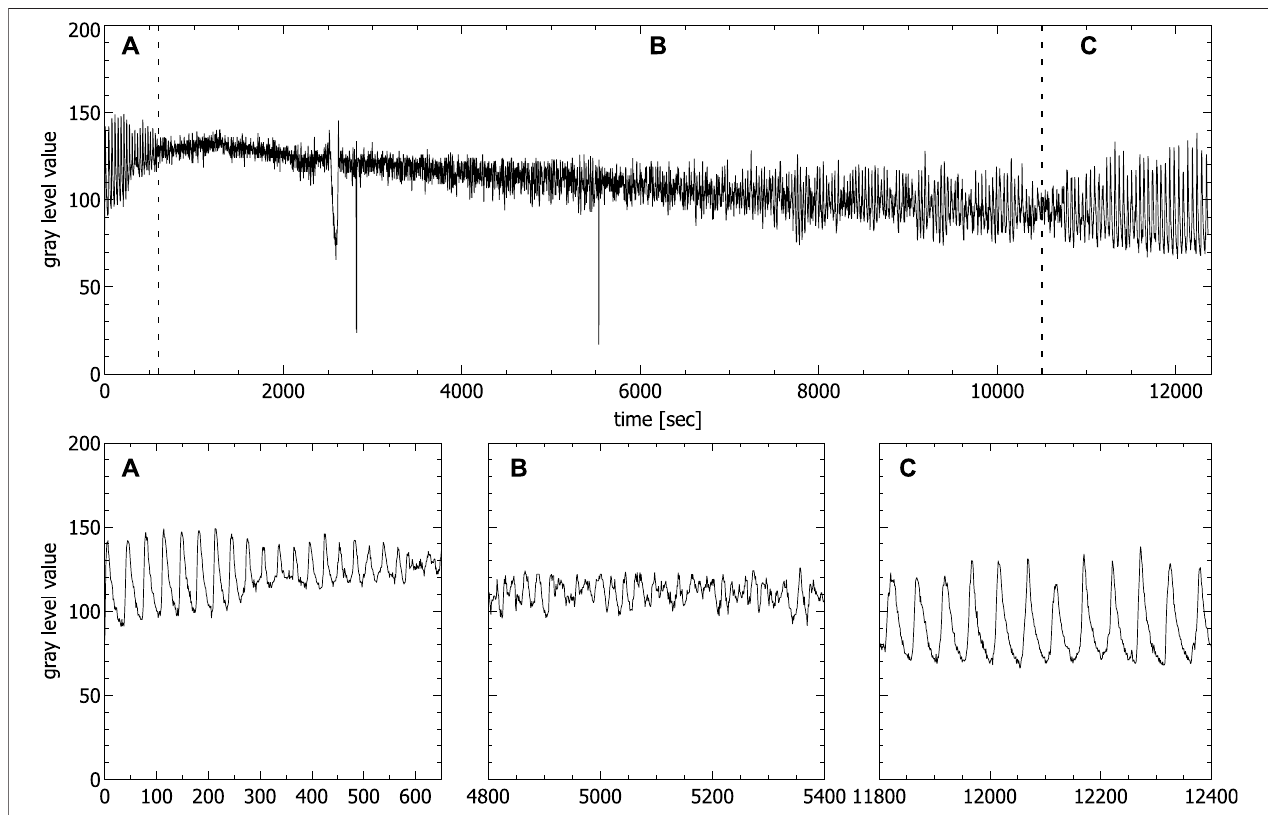
FIGURE 3 | Oscillations of the concentration of the ferriin concentration extracted from video data of an unstirred BZ reaction carried out in a fully fi lled standard cuvette (spikesinthetime seriescorrespond tothepassageofbubbles).Panels A – C showtheenlargementoftheareas A – C intheupper partcorrespondingtothe fi rst periodic (A) , the chaotic (B) and the second periodic phase (C) ,